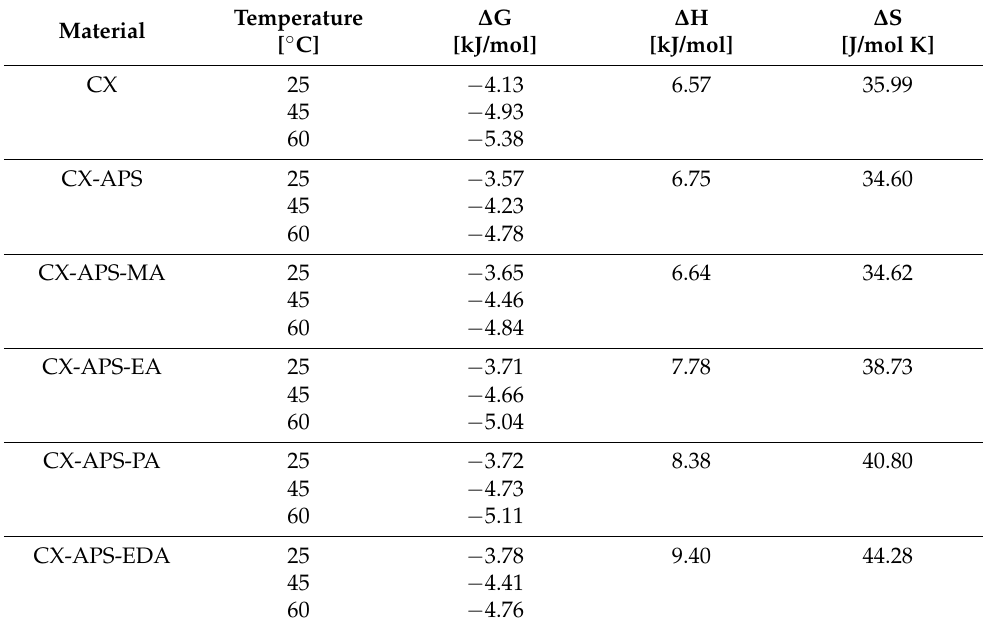
Table 6. Thermodynamical parameters calculated for the adsorption of thymol blue into carbon xerogels.